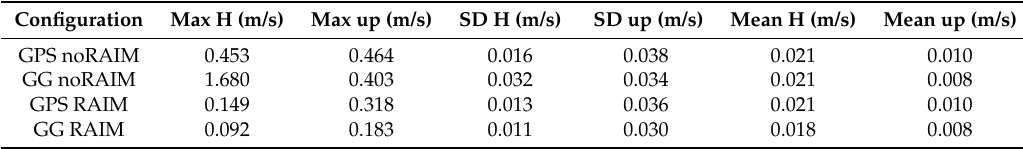
Table 9. Velocity error statistics considering only common reliable